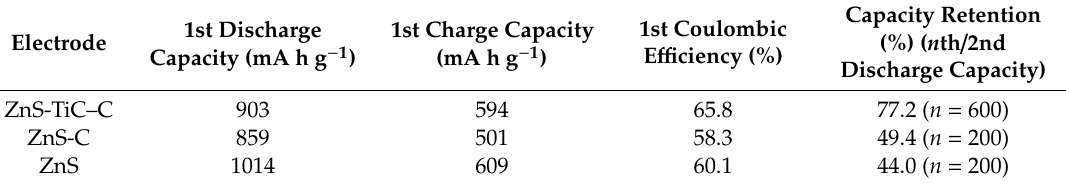
Figure 6. ( a ) Cyclic performance of the ZnS, ZnS-C, and ZnS-TiC-C electrodes at 0.1 A g − 1 ; ( b ) long-term cyclic performance of the ZnS, ZnS-C, and ZnS-TiC-C electrodes at 1 A g − 1 ; ( c ) comparison of the long-term cyclic performance of the ZnS-TiC-C electrodes at 0.1, 0.5, and 1 A g − 1 ; ( d ) rate capability of the ZnS, ZnS-C, and ZnS-TiC-C electrodes; ( e ) normalized capacity retention of the ZnS, ZnS-C, and ZnS–TiC–C electrodes at different current densities ranging from 0.1 to 10 A g − 1 ; and (f) electrochemical impedance spectra of the ZnS, ZnS-C, and ZnS-TiC-C electrodes after 50 cycles. Table 1. Electrochemical data for the ZnS-based electrodes.